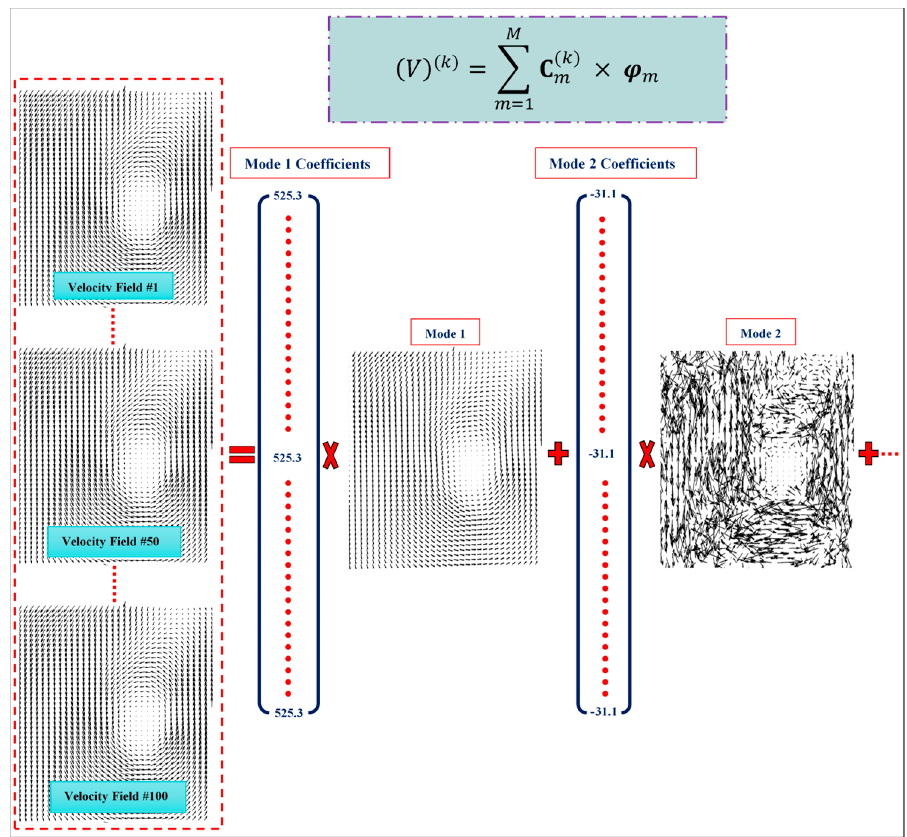
Figure 5. Illustration of POD for repeated identical flow structures.